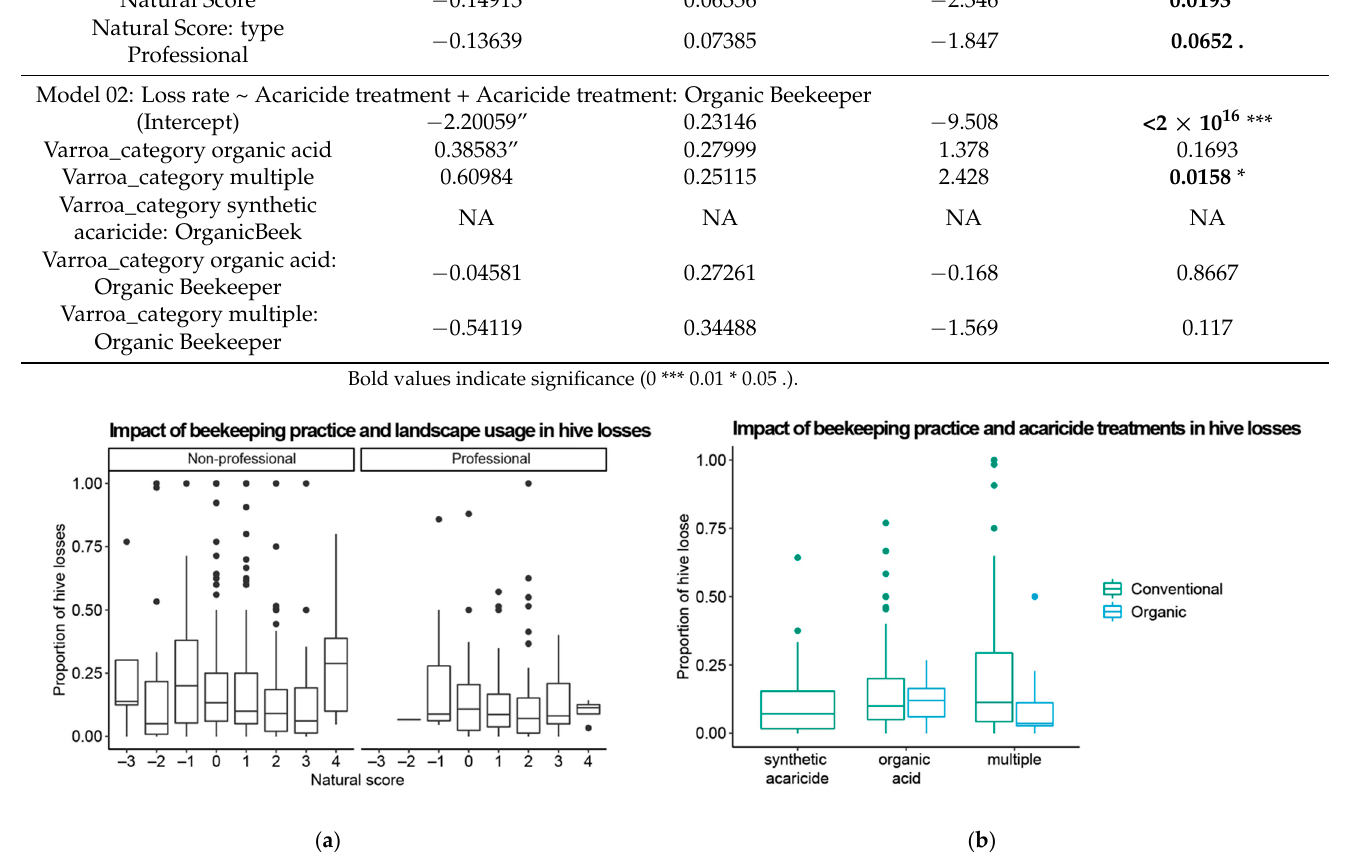
Figure 5. The use of natural habitats and the combination of several acaricide treatments are significantly associated with reduced colony losses: ( a ) box plots showing the variation in hive losses in relation to the natural scores obtained by beekeepers for the non-professional and professional categories; ( b ) box plots showing the variation in hive losses according to the type of acaricide treatment and the declarations of the beekeepers concerning their type of practice.